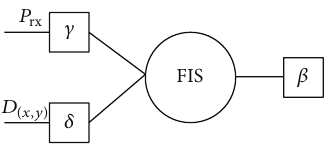
Figure 6: The decision-making system designed to update the adjustment